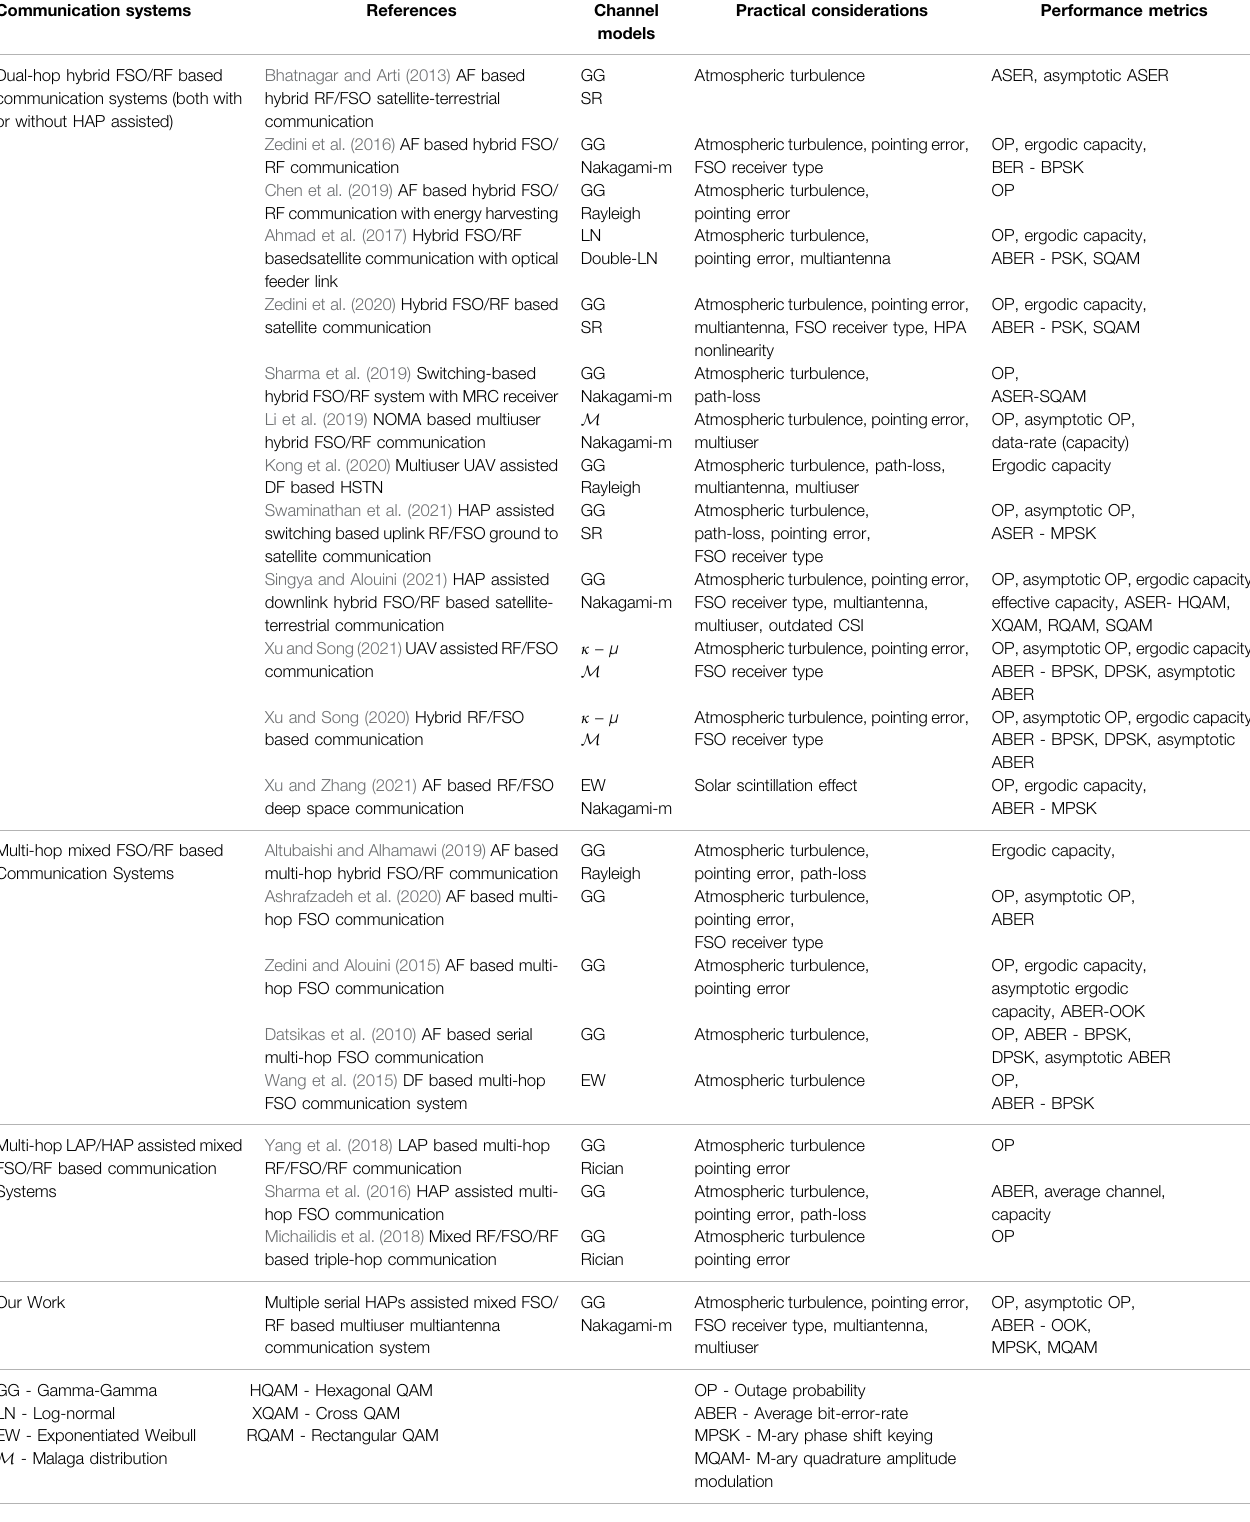
TABLE 1 | Various related